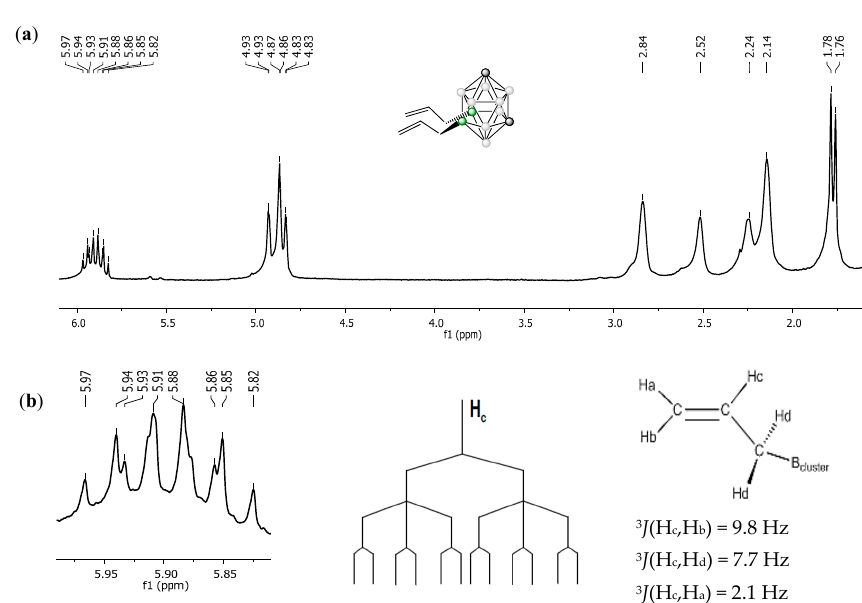
Figure 4. ( a ) The 1 H { 11 B} spectrum of 3 in CDCl 3 . ( b ) H c allyl resonance as well as the schematic coupling between H c protons and the protons of the allyl branches with the corresponding coupling constant values.